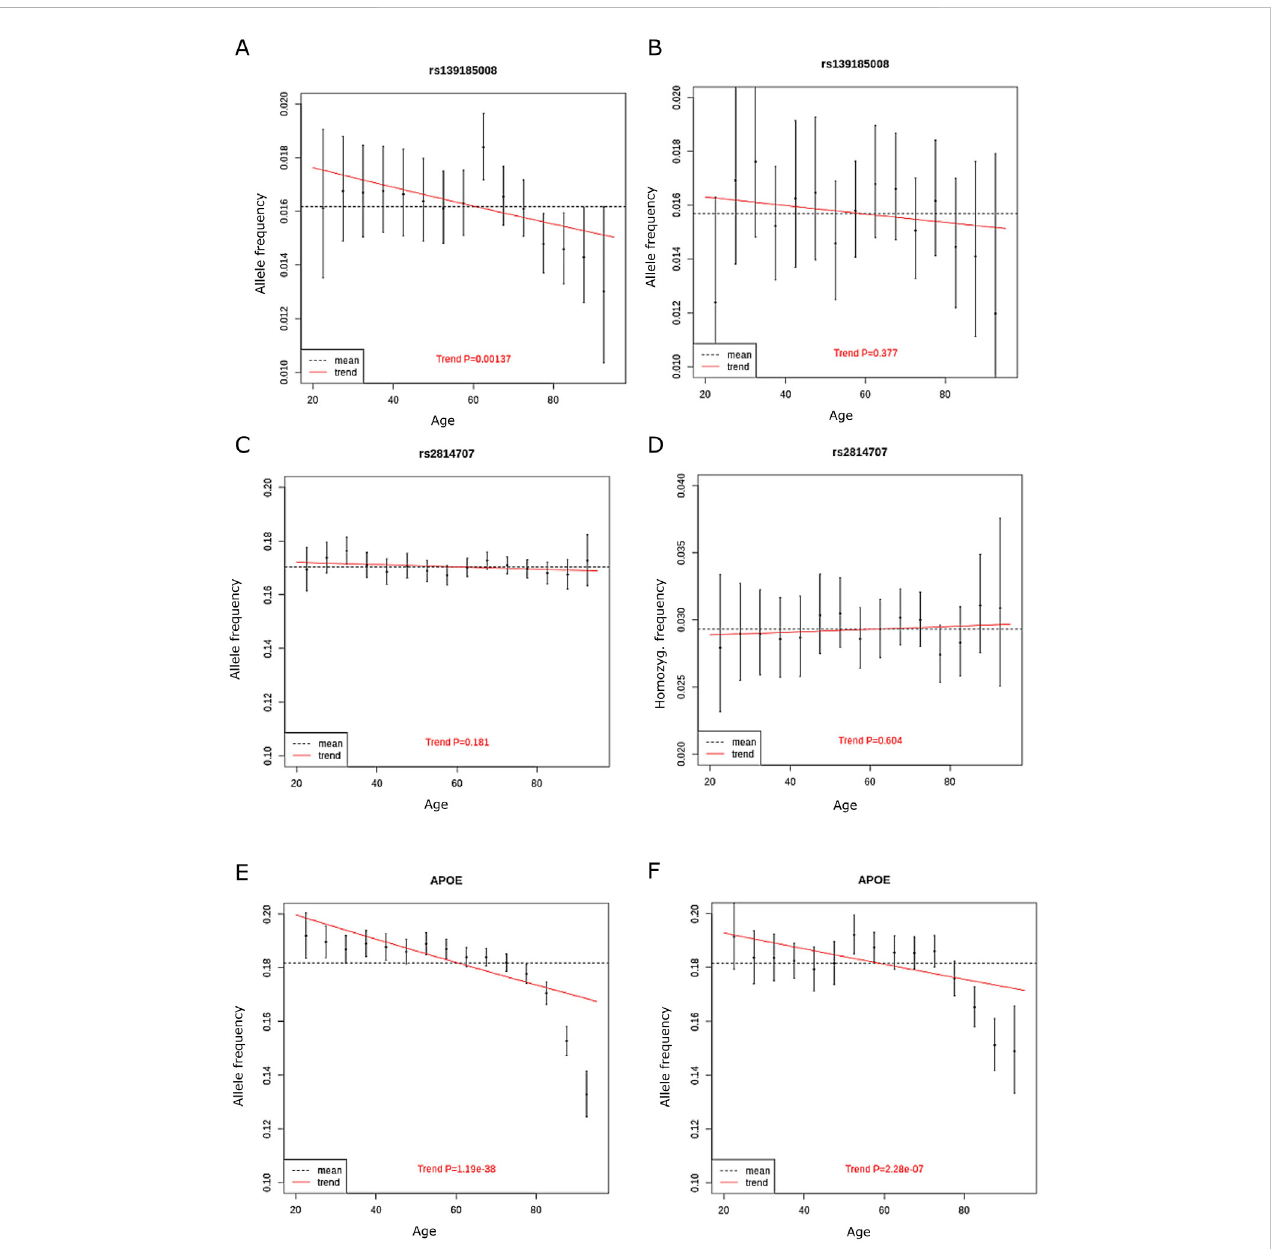
The allele frequency of (A) rs139185008*C in discovery cohort in 5-year bins (B) , rs139185008*C in replication cohort in 5-year bins (C) rs2814707*T n discovery cohort (D) rs2814707*T homozygote frequency in discovery cohort (E) APOE ε 4 allele frequency in discovery cohort and (F) APOE ε 4 allele frequency in replication cohort. The red line shows the trend in allele frequency with age, the allele frequency estimate across all age groups is shown by the dashed